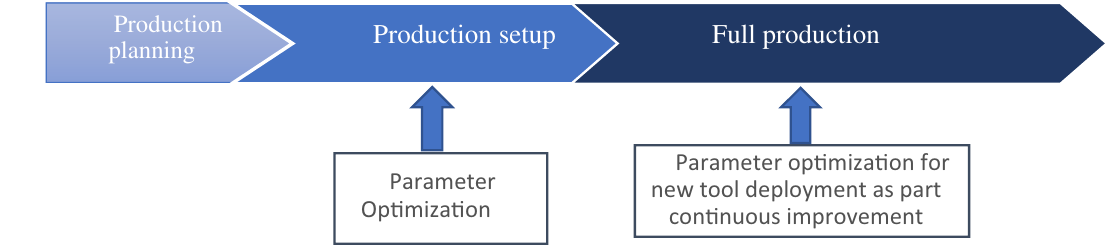
Fig. 1 Sequence of production evolution and the parameter optimization interventions in different